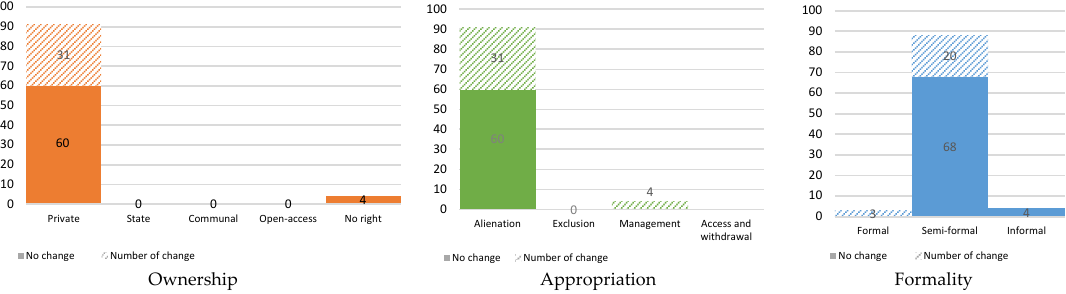
Figure 8. The number of property rights transformation on cultivated lands in KBP.